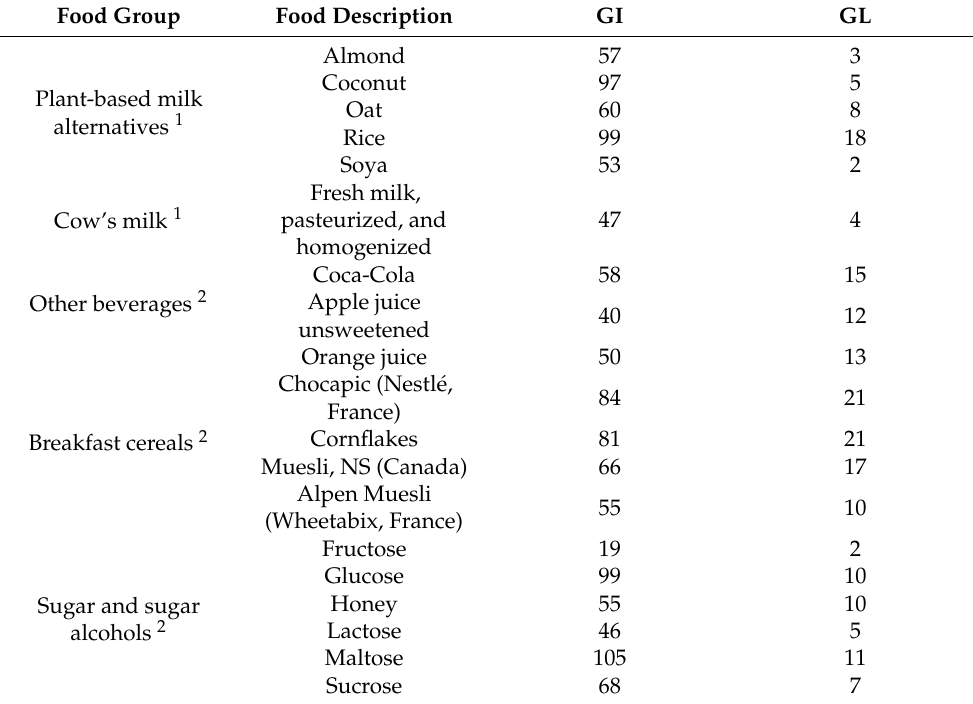
Table 2. Glycemic index (GI) and glycemic load (GL) values of different types of food. Food